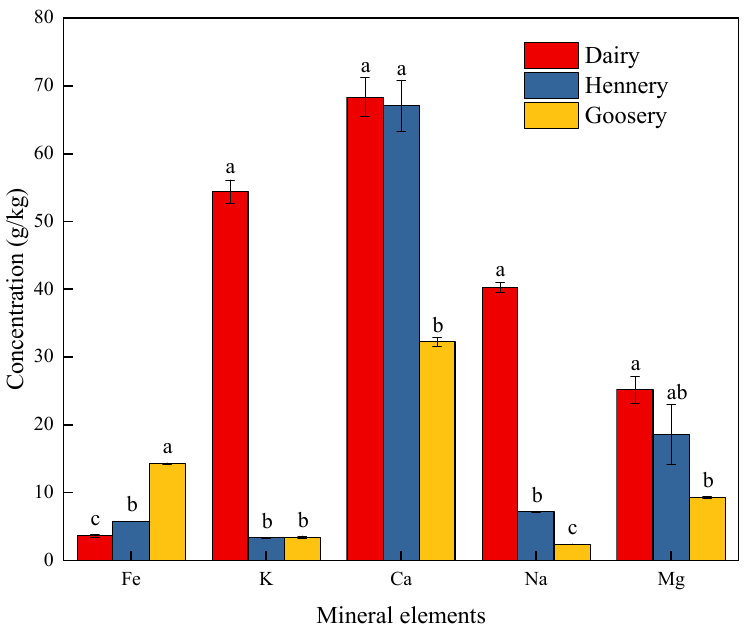
Figure 5. Concentrations of mineral elements in biogas residues from three types of farms. Different letters indicate significant differences between different types of farms ( p < 0.05).